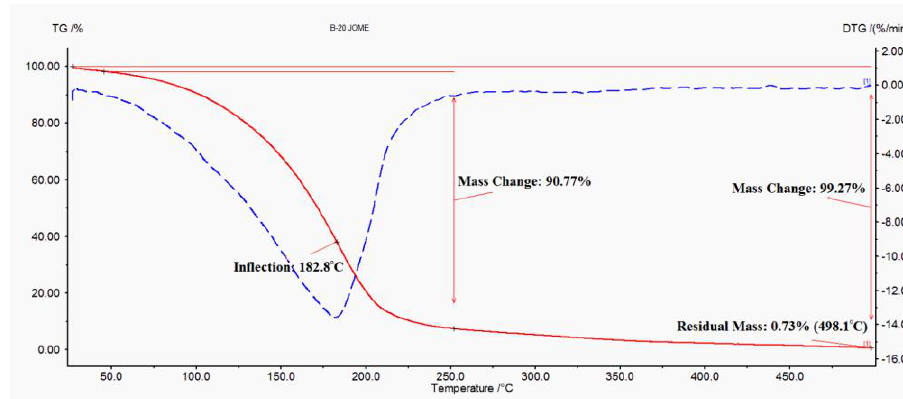
Figure 5. TG-DTG curve for B20 JOME.